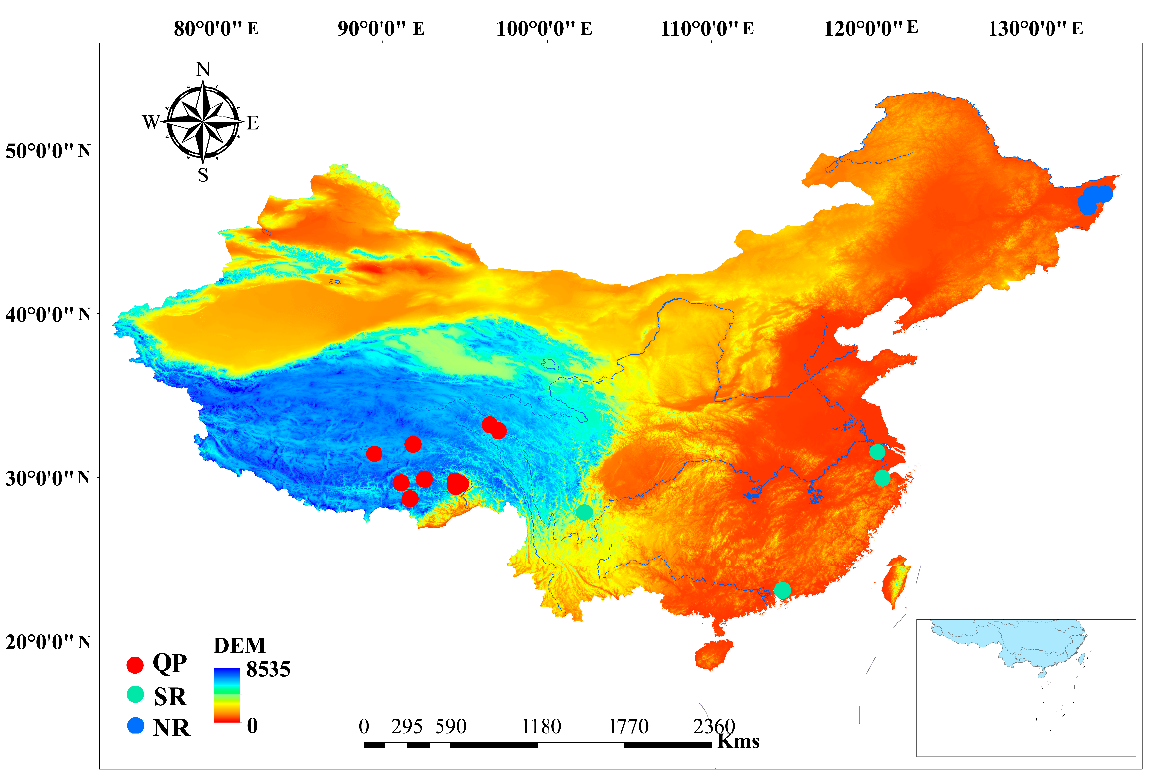
Figure 1. Map of China showing the sampling localities of the species Lumbriculus variegatus used in this study. QP, SR, and NR portions in the circle represent the Tibetan region, Southern China, and Northeast China.